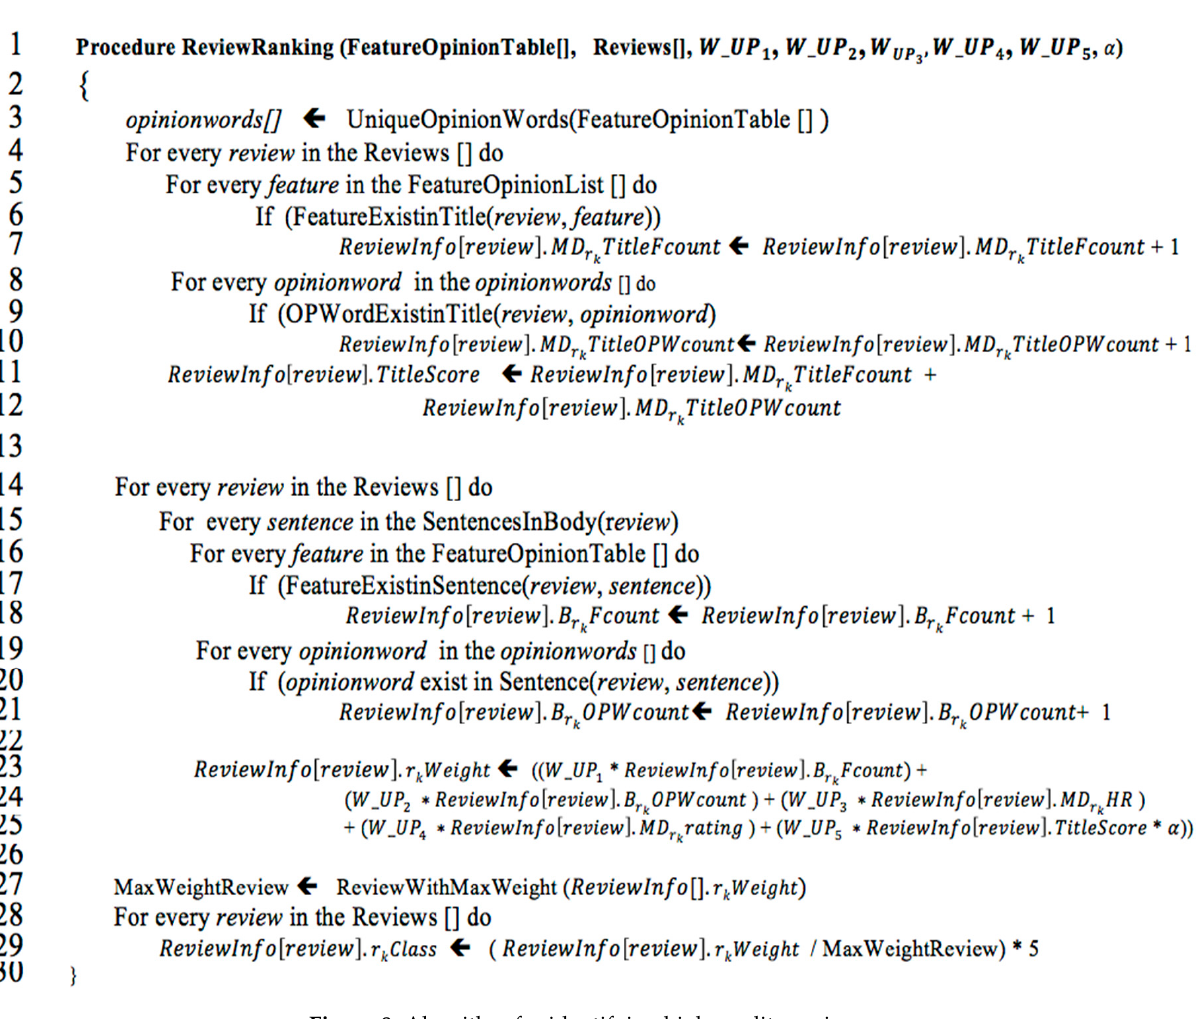
Figure 8. Algorithm for identifying high ‐ quality reviews.